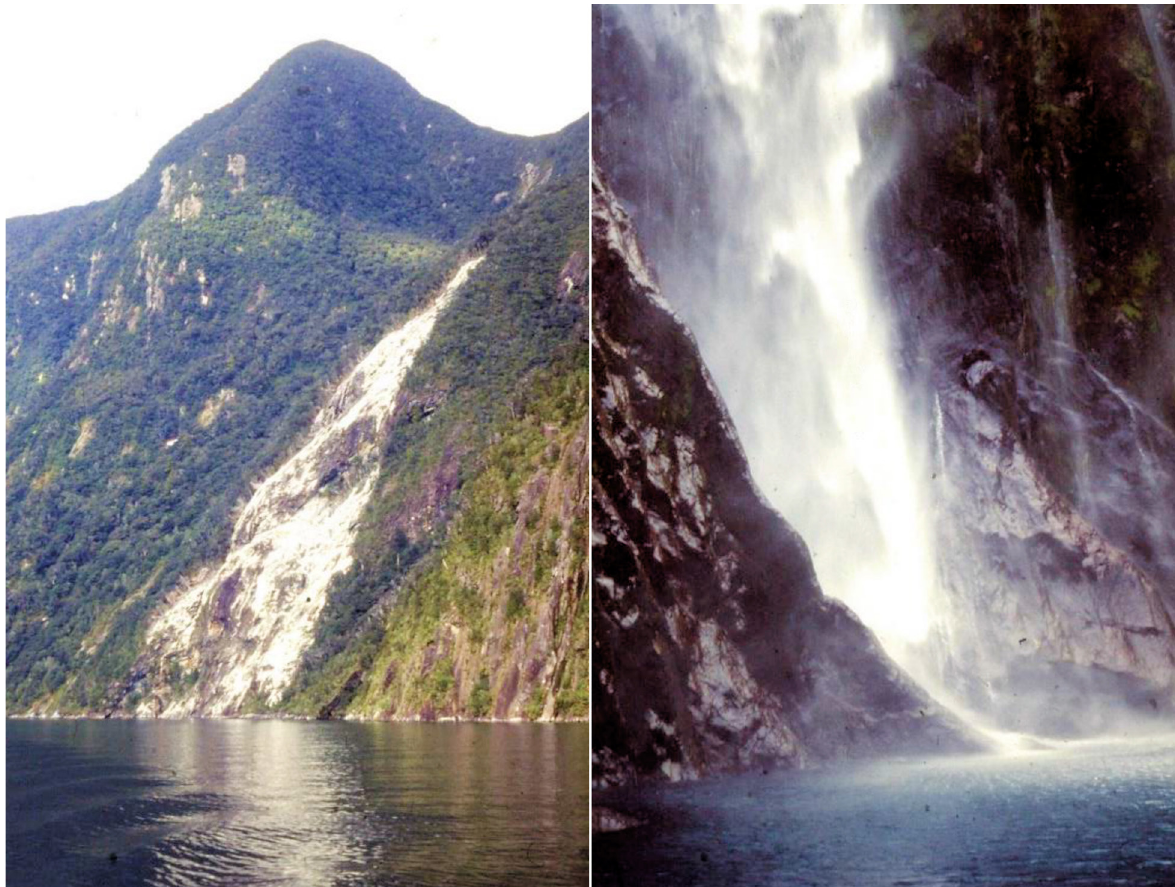
Fig. 6. Waterfalls in the glacially overdeepened fjord of Milford Sound, New Zealand. Photo: August